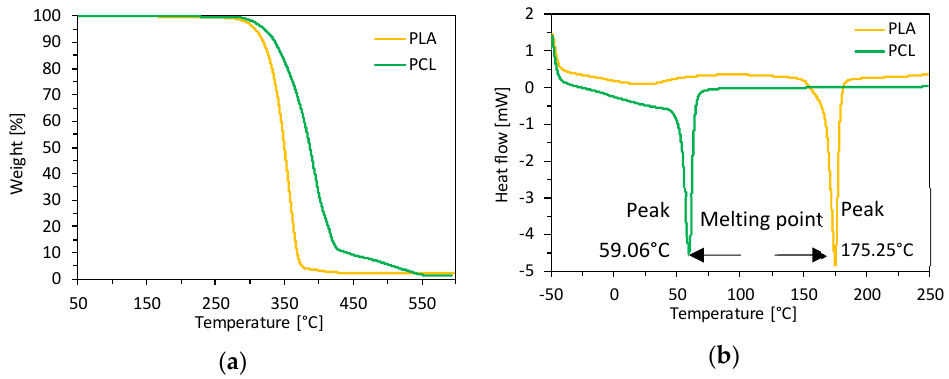
Figure 1. PLA and PCL ( a ) thermogravimetric analysis (TGA), and ( b ) differential scanning calorimetry (DSC). Table 1. Thermal stability estimators for the investigated biopolymer samples.